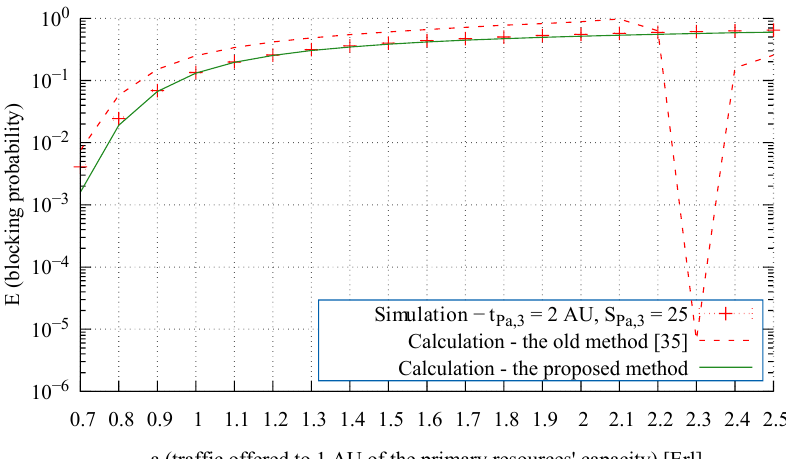
Figure 11. Blocking probability of the Erlang traffic class t Er,1 = 7 in the secondary resources in System 2.